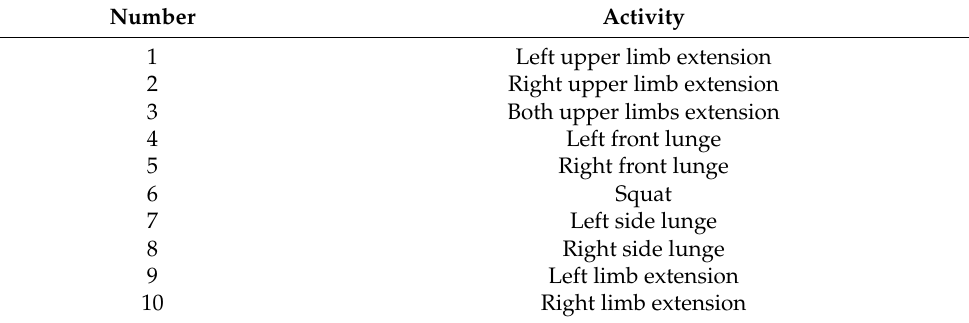
Table 1. The 10 activity types of the MARS dataset [7].